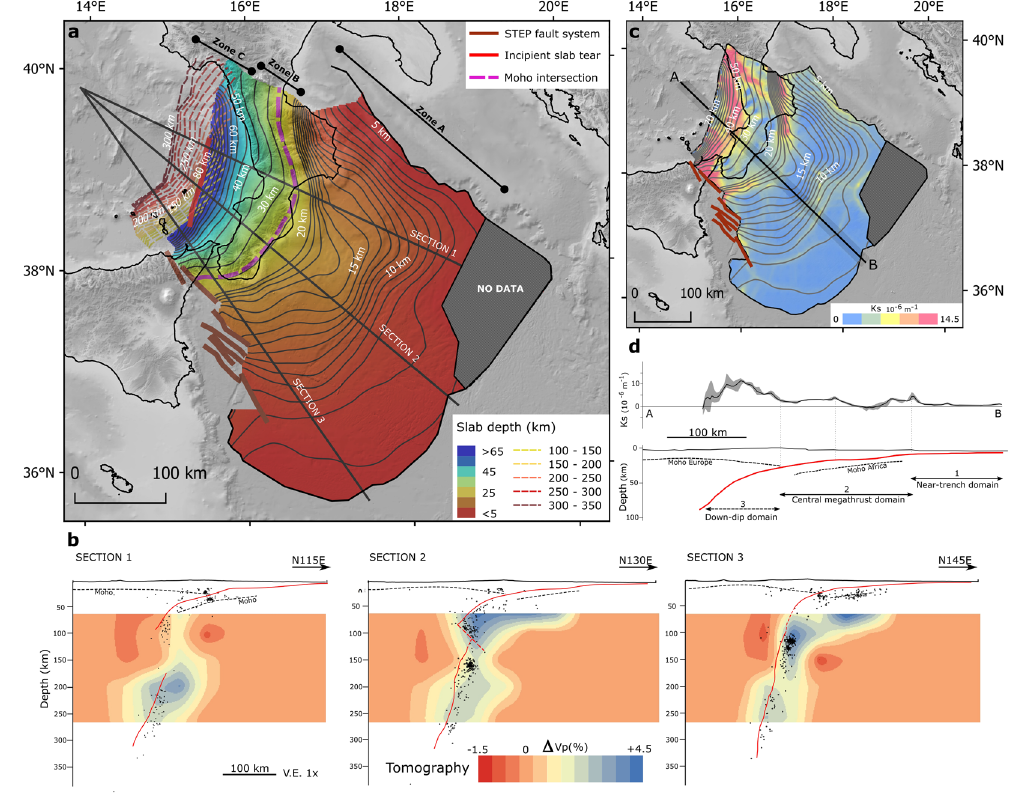
Figure 8. Integrated slab model. Panel a – Gradient-colour map and depth contours of the integrated slab model (smoothing distance = 50 km). Depth contour intervals is 1 km between 5–20 km depth, 5 km between 20–100 km depth, and 10 km from 100 km depth downward. Zone A is the area covered by seismic reflection profiles (Fig. 6), Zone B is the transition zone obtained through interpolation, and Zone C is the subduction interface interpreted from the distribution of instrumental seismicity. The Moho depth 73 model is from GeoIT3D 74 . Panel b - Sections across the slab. Red line is the position of the subduction interface shown in Panel a. Red dashed line in Section 2 is the incipient slab tear. Black dots are the earthquakes collected in 10-km- wide buffers around the section traces. Dashed black line is the position of the Moho from Scrocca, et al . 73 . Tomographic data are from Neri, et al . 50 . Panel c - Map of the interface curvature Ks = d Θ /d s , where Θ is the dip angle and s is the tangent to the interface 2 . The depth contours from Fig. 8a are shown for reference. Panel d - Swath profile A-B (width = 20 km) of the curvature and a sketch of a possible zonation. Topo-bathymetric relief (Panel a) and profile (Panel c) are obtained from SRTM30_PLUS 72 . Coastlines are from the European Environmental Agency